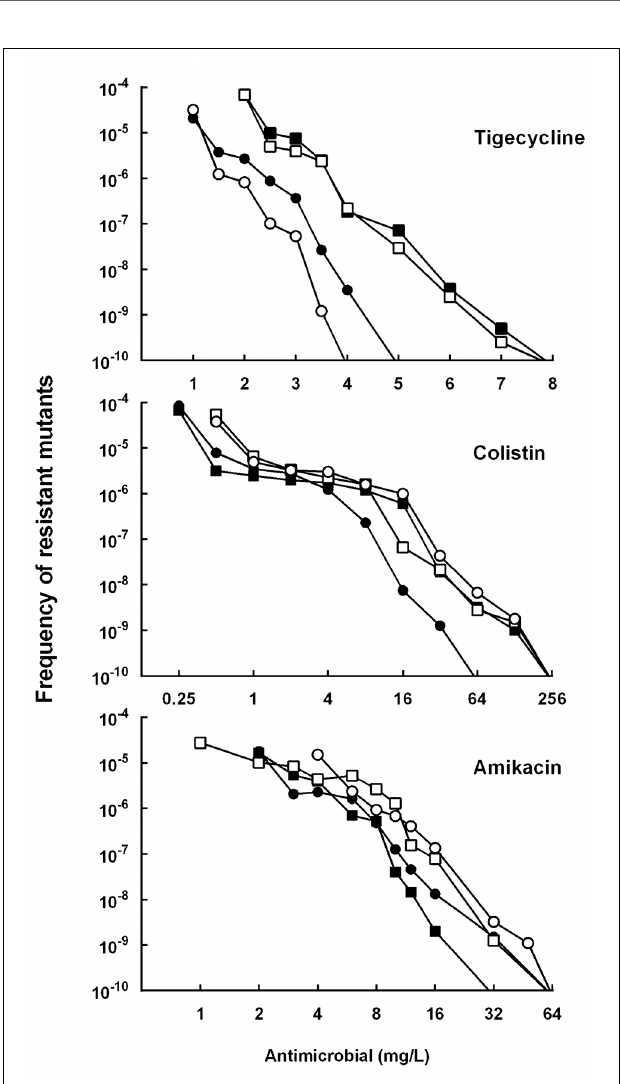
FIGURE 3 | Effect of antimicrobial concentration on recovery of mutants in K. pneumoniae strain Kp3 (filled circles), Kp18 (filled squares), Kp8 (open circles), and Kp23 (open squares) were applied to agar plates containing the indicated concentrations of